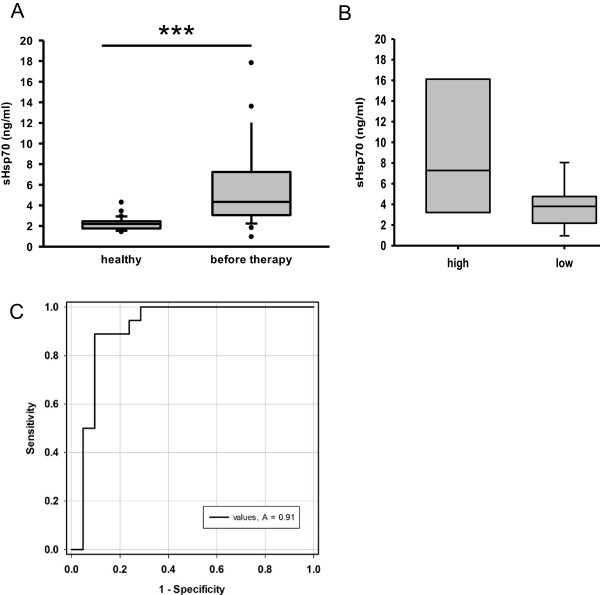
sHsp70 serum levels in blood of patients with SCCHN. A. sHsp70 concentrations in sera of patients (n = 21) before therapy compared to healthy donors (n = 28). B. sHsp70 serum data from patients were separated into two groups (high n = 11, low n = 10) reflecting the mHsp70 membrane expression as measured in A. C. Standard box plots are shown with boundaries indicating the 25th and the 75th percentile. The line inside boxes indicates the median and the whiskers indicate the 10th and 90th percentile, respectively. All outliers are shown. (***p < 0.001) C. ROC curve of data from (A) were attained by SigmaPlot software showing an AUC of 0.9101 (p < 0.0001, CI 95%). The cut-off level was 2.5 ng/ml with a sensitivity of 89% and a specificity of 91%). Abbr.: ROC, receiver operating characteristic; AUC, area under the curve; CI, confidence interval.